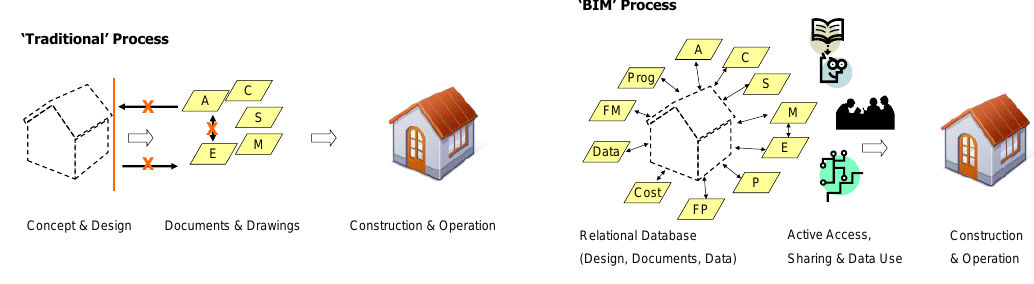
Figure 2 A Comparison between “Traditional” and “BIM” Process (Courtesy of: Holder Construction, Atlanta, Georgia,